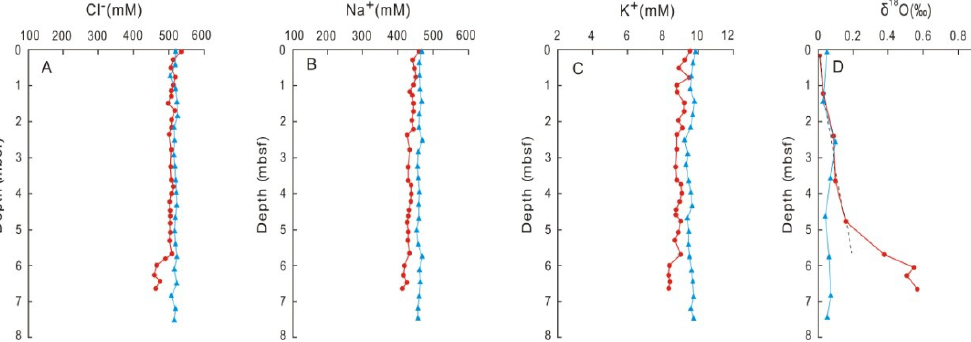
Figure 3. ( A ) δ 18 O values of sulfate in C9 (blue) and C14 (red); ( B ) δ 18 O pore water sulfate of C9 (blue) and C14 (red). δ 34 S